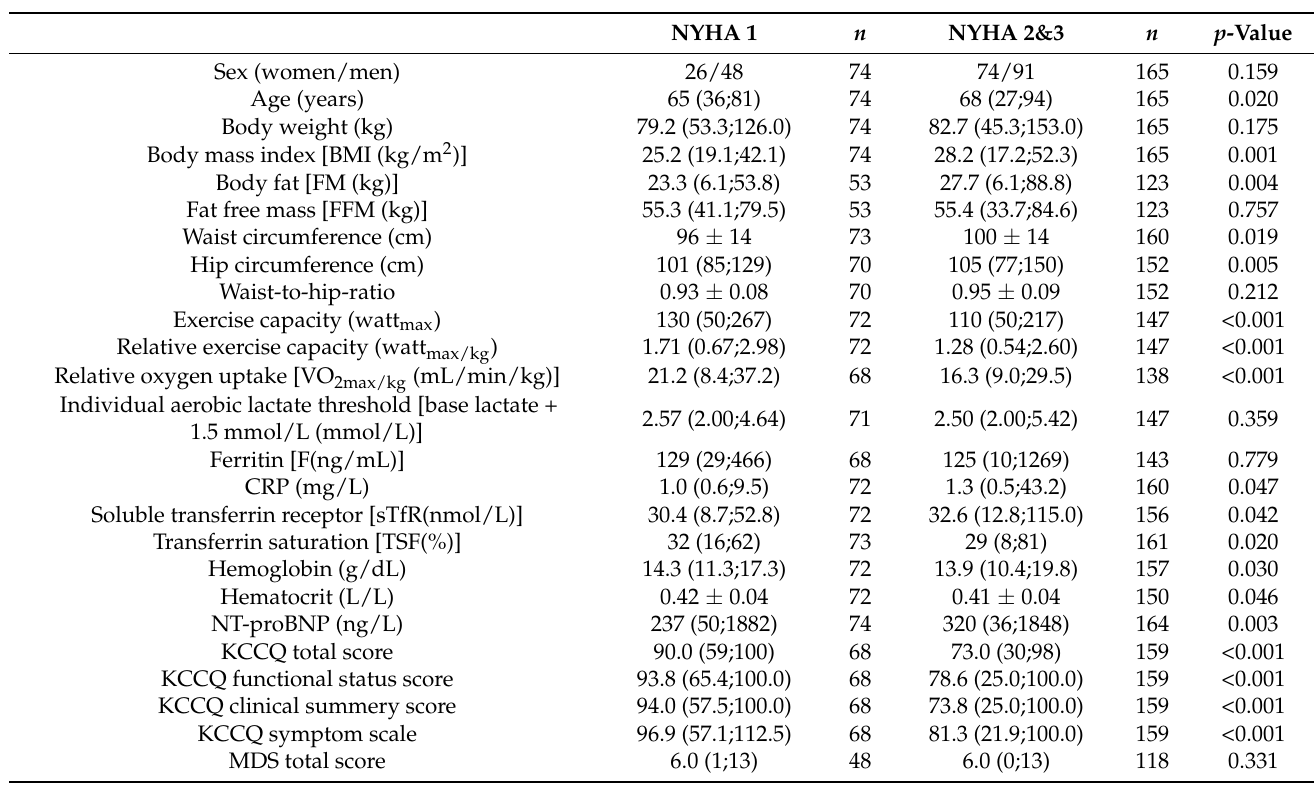
Table 1. Subject